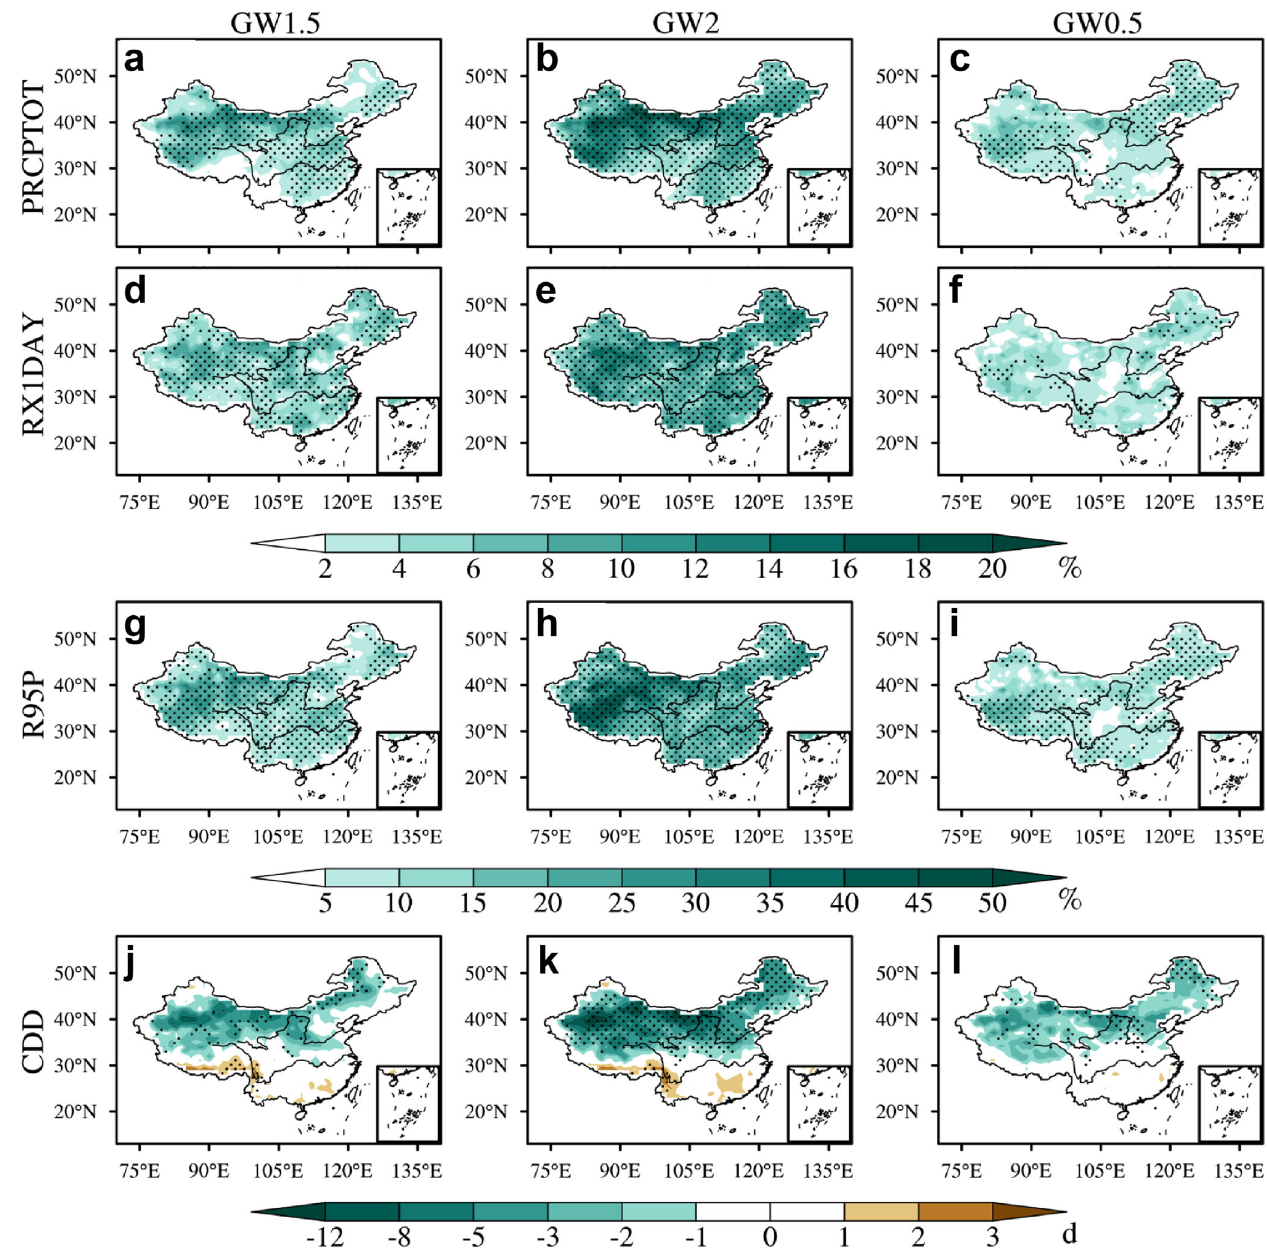
Fig. 5 Annual total wet-day precipitation change (PRCPTOT) and three extreme precipitation indices (RX1day, R95p, and CDD) change in China at GW1.5 and GW2.0. The left-hand column shows the changes at GW1.5 while the middle-hand column shows GW2.0, and the right- hand column shows additional changes due to the additional 0.5 °C warming (GW2 as compared with GW1.5). Results are based on the multi- model ensemble mean (MMEM) of Coupled Model Intercomparison Project Phase 6 (CMIP6) models relative to 1995 – 2014. Areas with signi fi cant changes above 95% con fi dence are marked with black